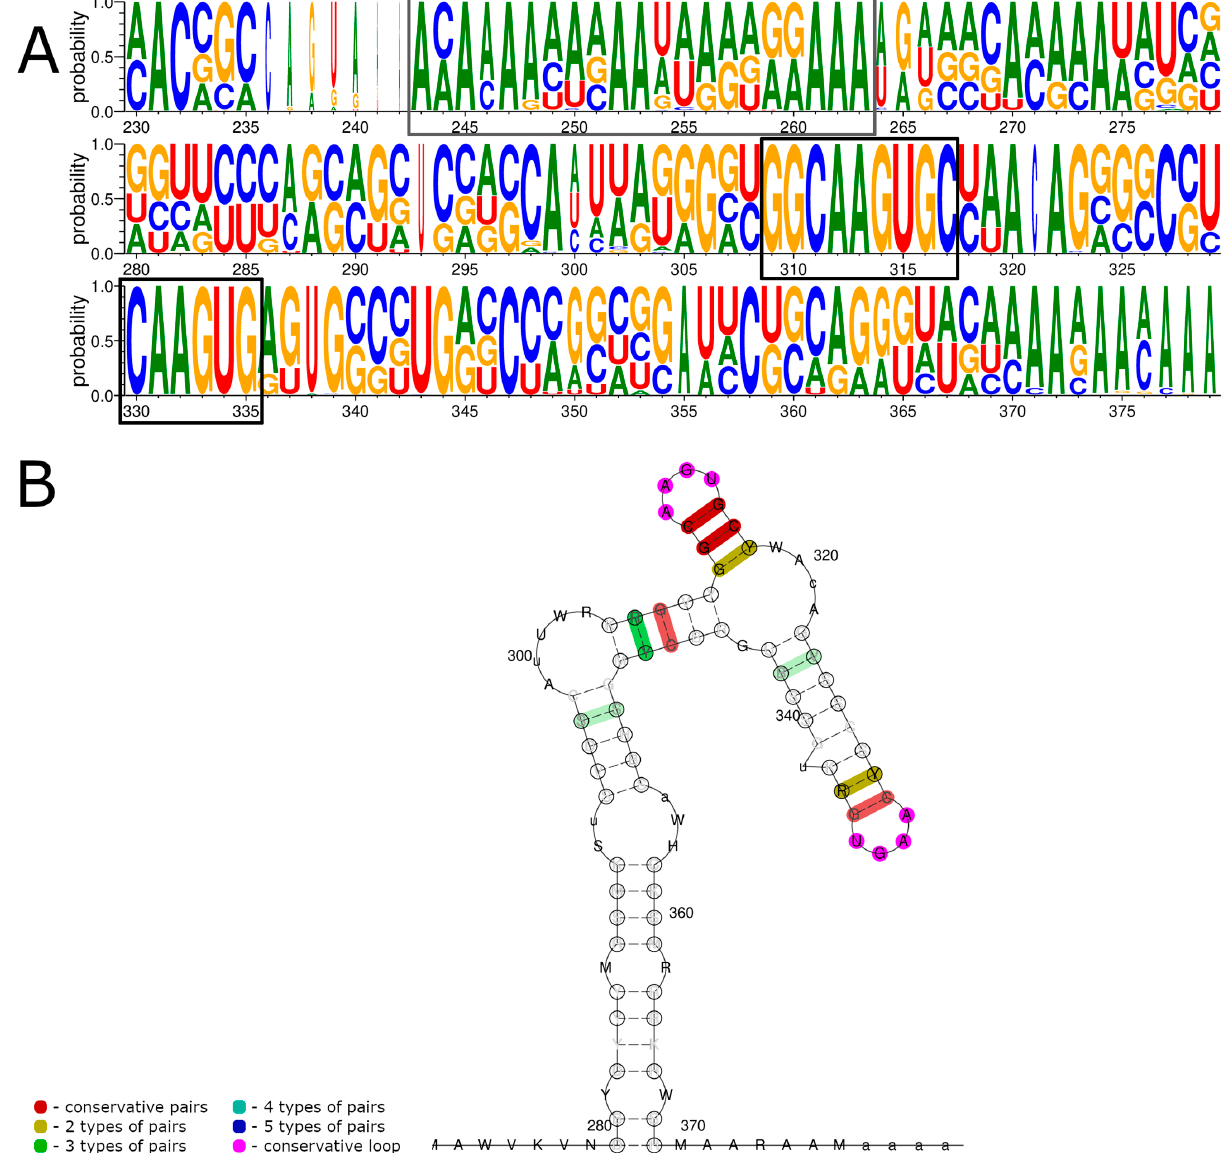
Figure 4. Consensus sequences of JMTV 3 ′ UTRs ( A ) and consensus structures predicted by Lo- cARNA ( B ). Conserved nucleotides in the consensus sequences are marked by black boxes. Nu- cleotide enumeration in fi gure ( B ) follows the enumeration in the alignment ( A ).